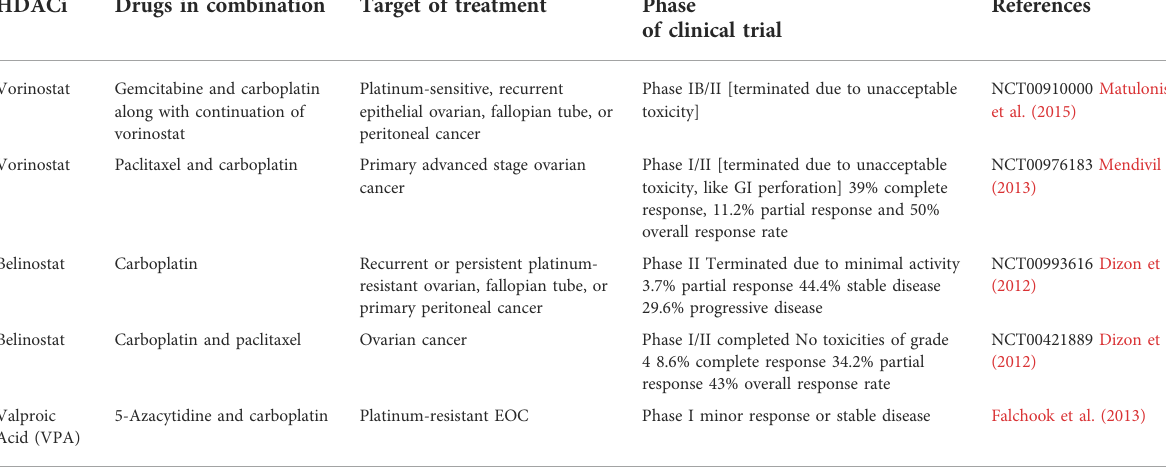
TABLE 8 Role of HDACi in combination with other drugs in clinical research.